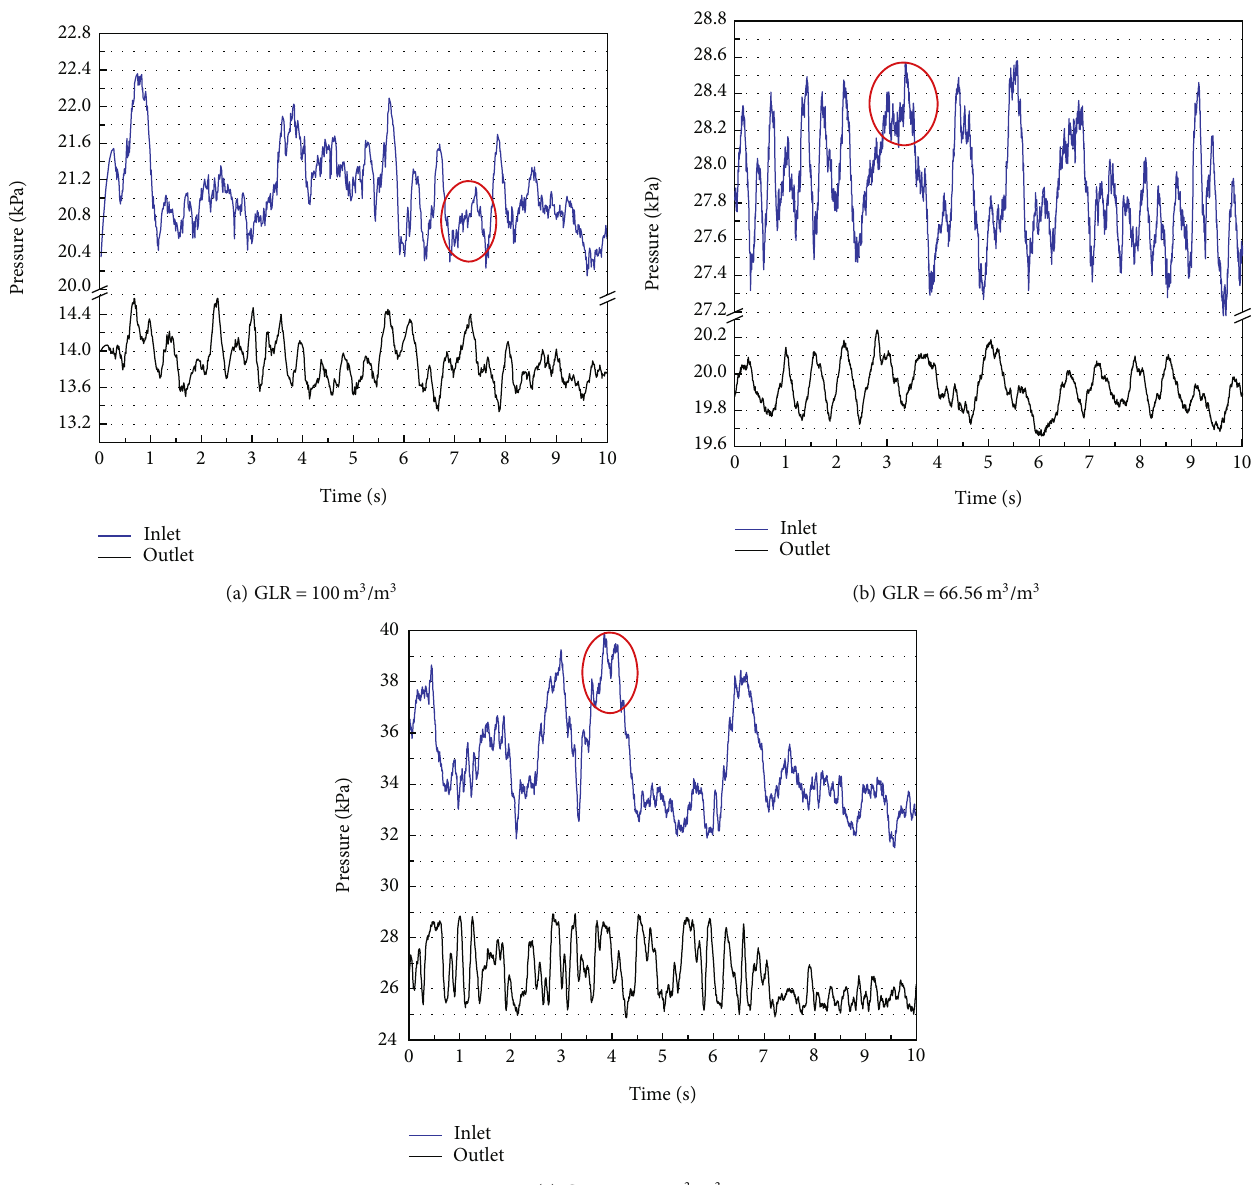
Figure 10: Pressure fl uctuation curve of the inlet and outlet with a di ff erent gas-liquid